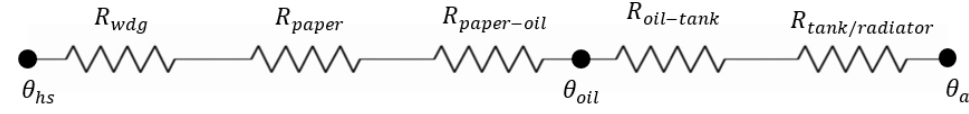
Figure 2. Thermal resistance equivalent circuit.